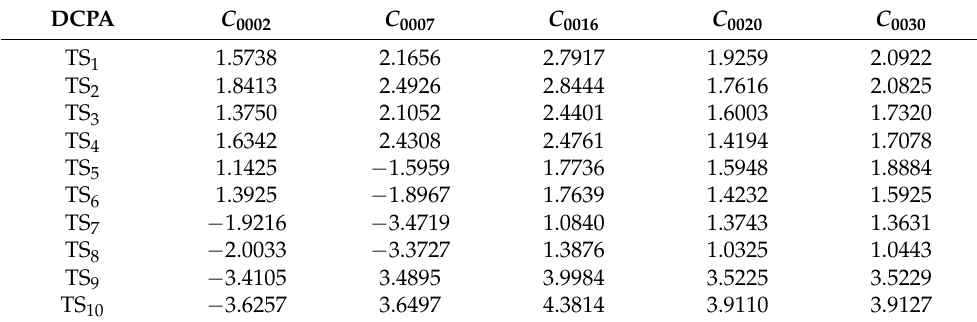
Table 6. DCPA of target